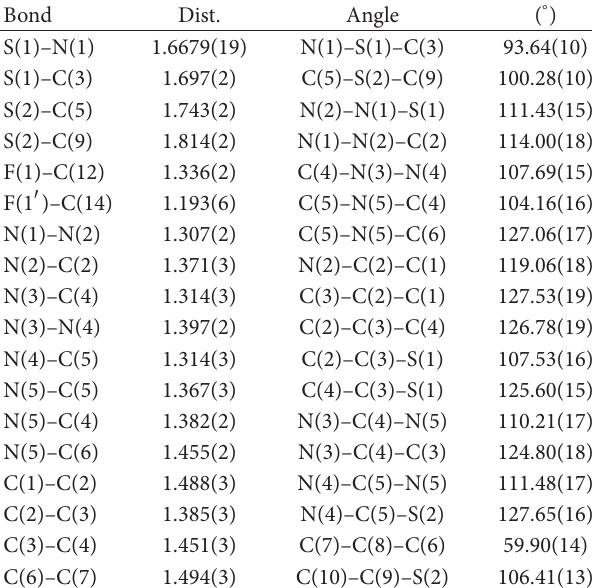
T 2: Selected bond lengths (Å) and bond angles